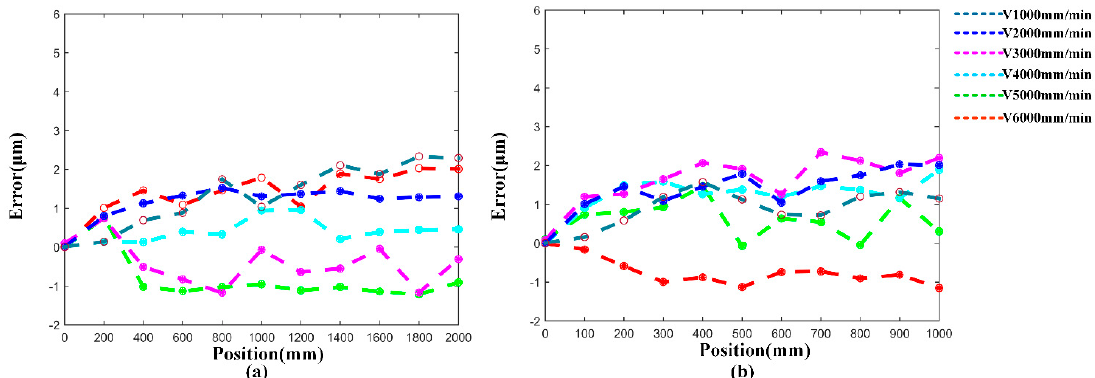
Figure 19. Non-delay error compensation results. ( a ) Non-delay error compensation results with the tool center moving along the X -direction; ( b ) non-delay error compensation results with the tool center moving along the Y -direction.